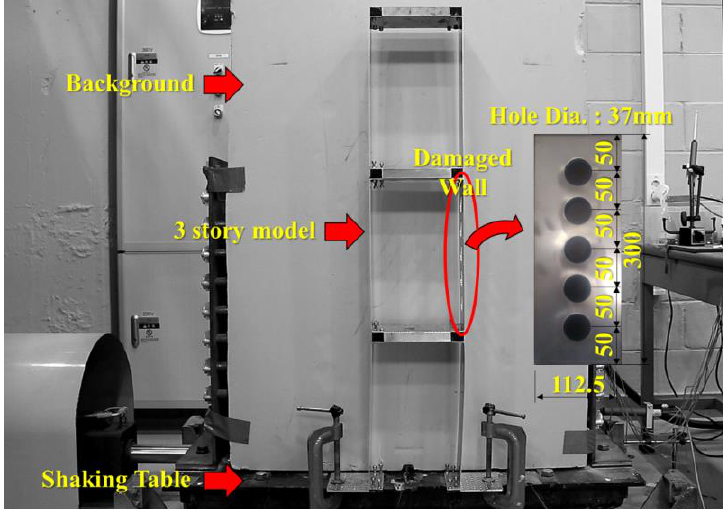
Figure 5. Setup for shaking table test.